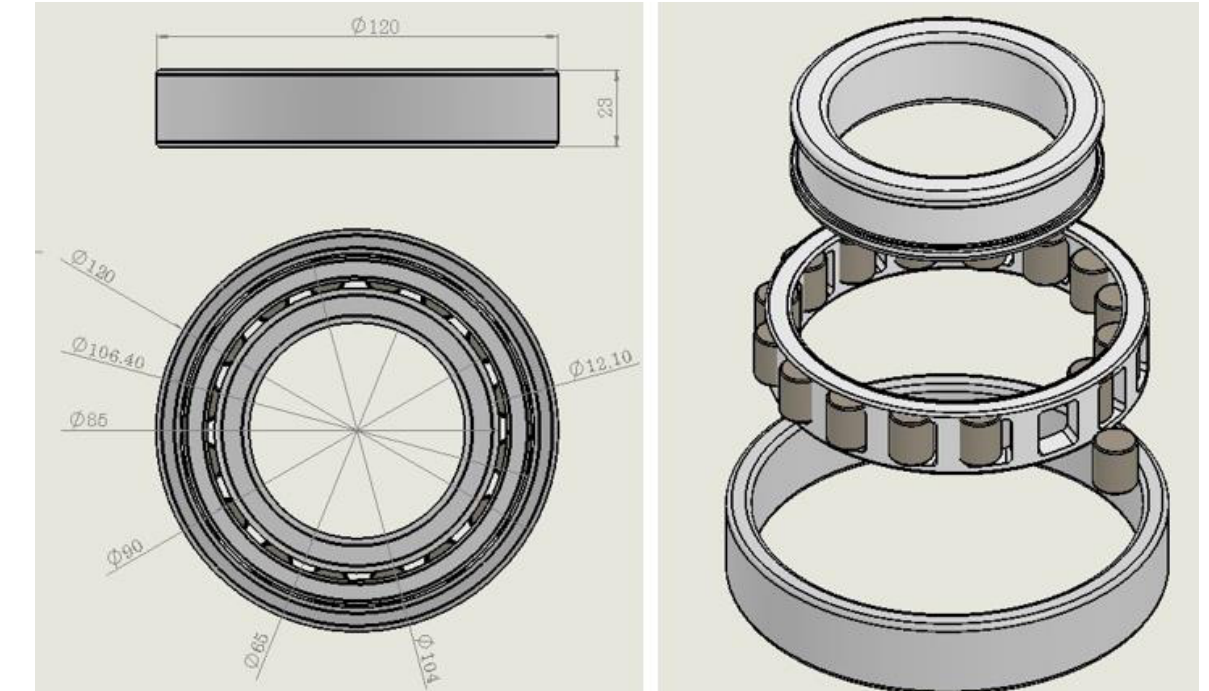
Figure A1. Bearing housing dimensions.